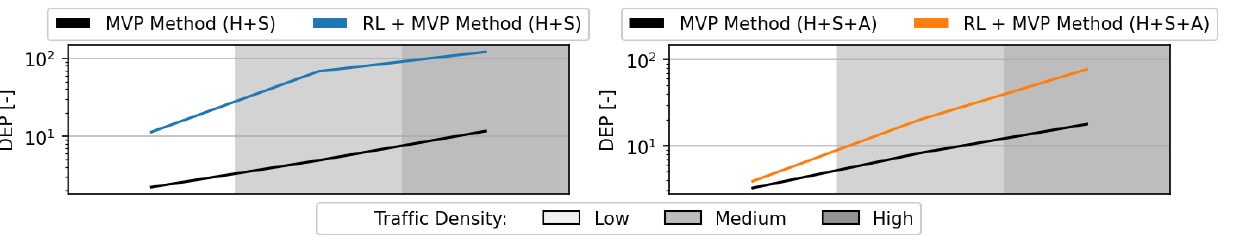
Figure 16. Domino effect parameter (DEP) during testing of the RL agent.